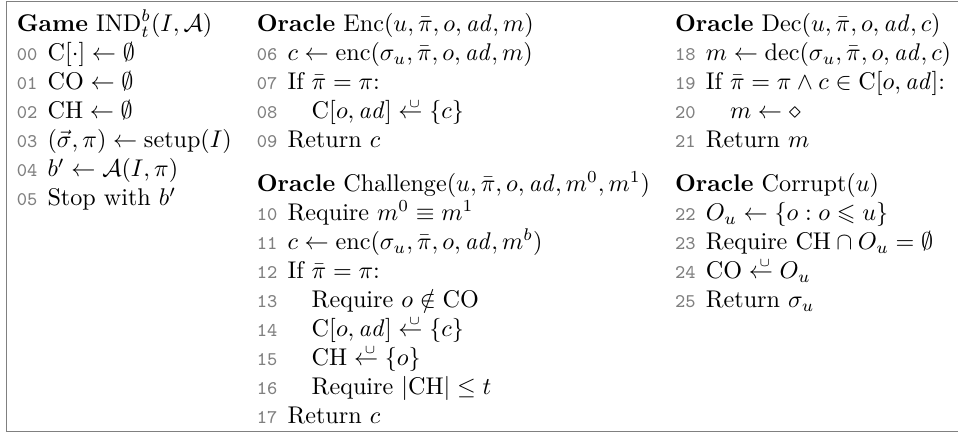
games for RWES (the SAFE and INT games are in Fig. 6). For all values Figure 7: IND b t u, ¯ π, o, ad , m, m 0 , m 1 , c provided by the adversary we require that u ∈ U , ¯ π ∈ Π, o ∈ O , ad ∈ AD , m, m 0 , m 1 ∈ M , c ∈ C . Read C like in ciphertext, CO like in corrupted object, and CH like in challenge. Assuming (cid:5) / ∈ M , we encode suppressed messages with (cid:5) . We refer the reader to Appendix F.5 for a further discussion.